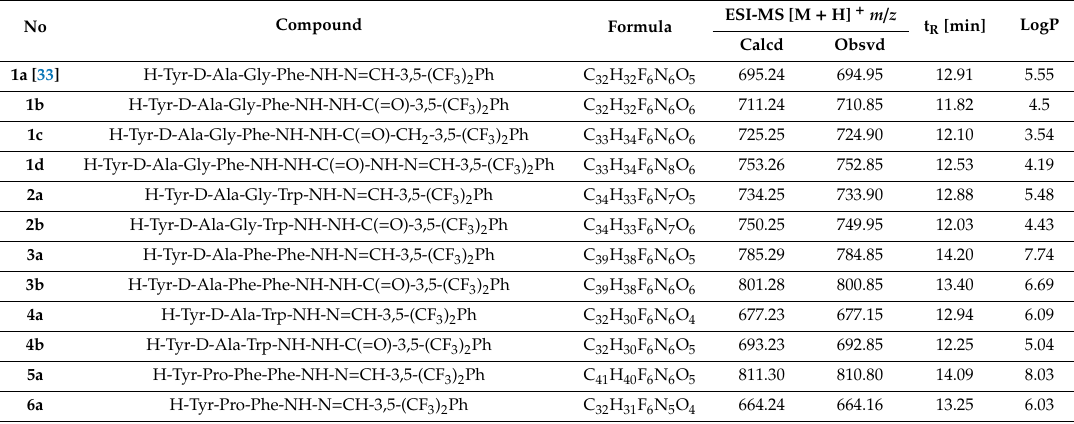
Figure 2. Structural variation of the reported compounds. Table 1. Analytical data for the synthesized